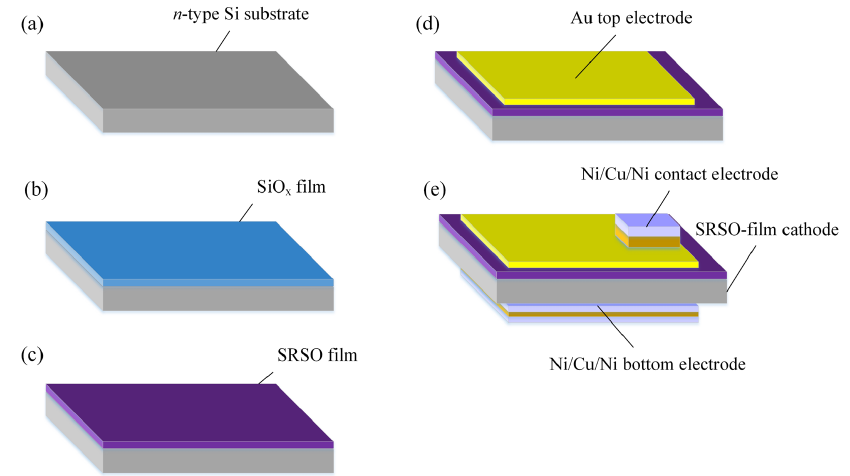
film deposition by reactive x